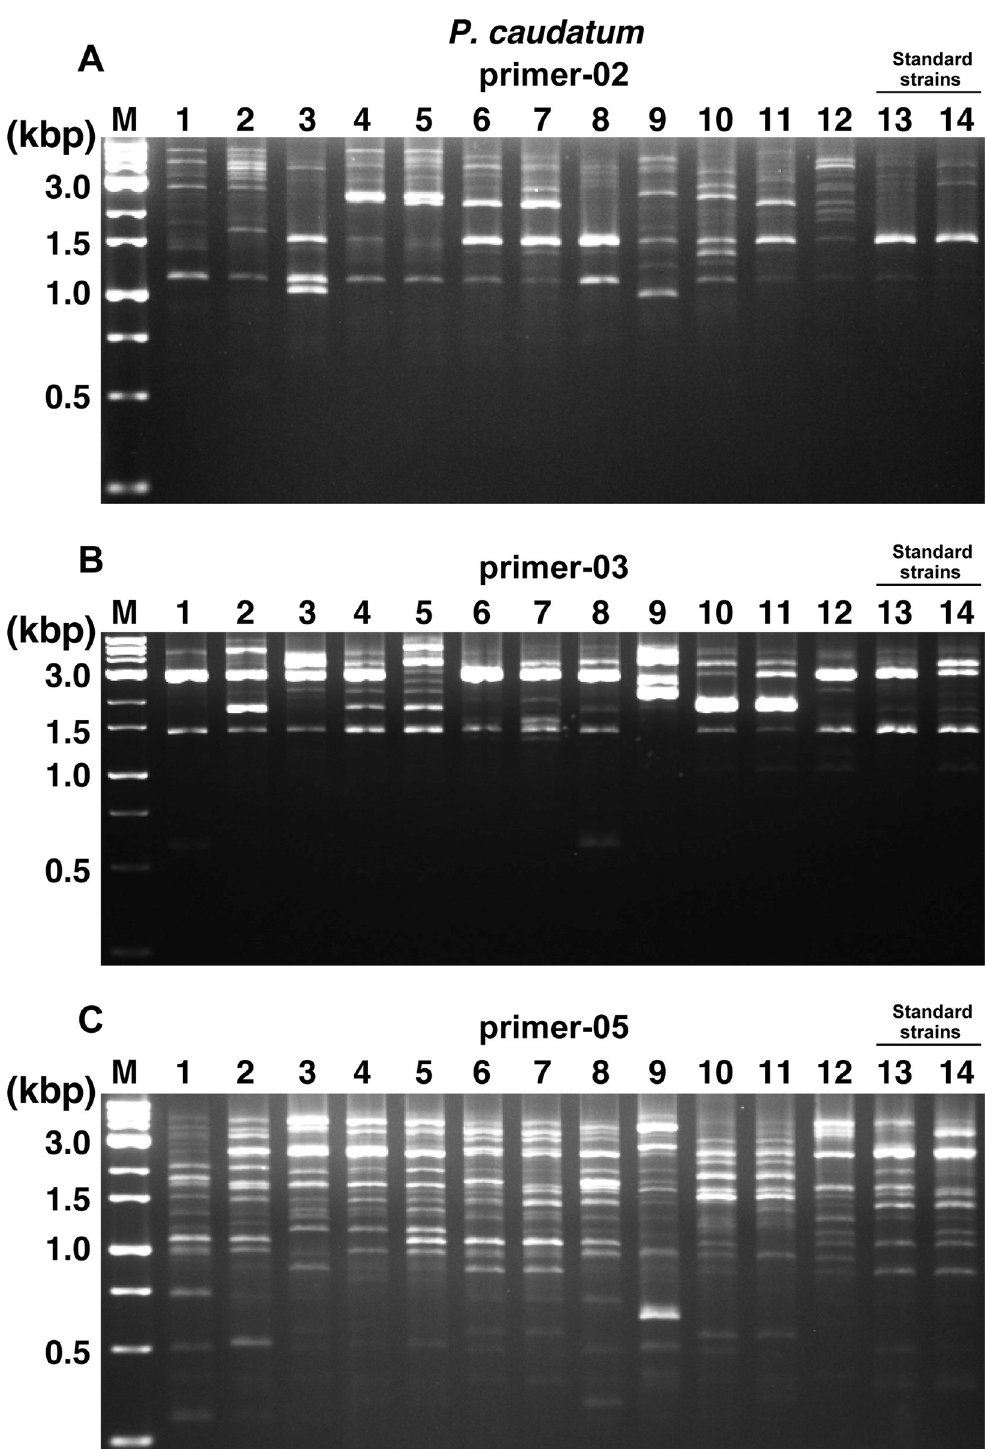
Fig 1. RAPD analysis using template DNA from P . caudatum strains. RAPD analysis using template DNA from 12 recommended strains (Nos. 1–12) and 2 standard strains (Nos. 13 and 14) of P . caudatum . The random primers used in each reaction are presented at the top of the figures (A, primer-02. B, primer-03. C, primer-05). M, weight marker.